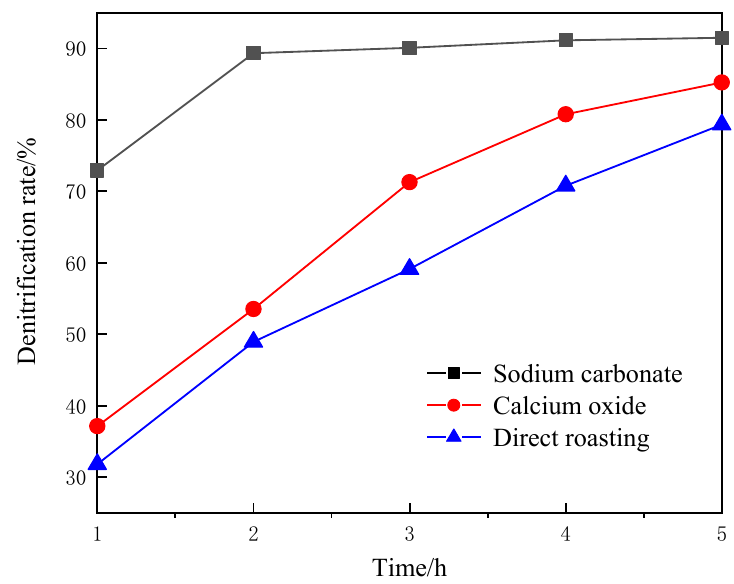
Figure 6. Denitrification rate of aluminum dross as a function of roasting time.